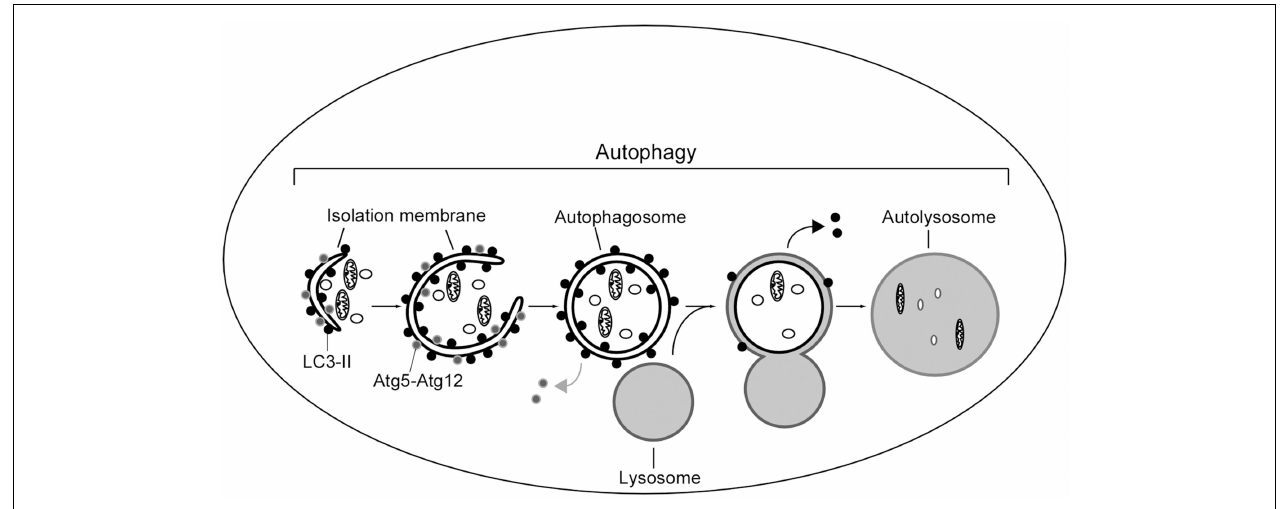
elongation process. LC3 is recruited to the membrane in the Atg5-dependent manner. Atg5–Atg12 dissociate from the membrane upon completion of autophagosome formation, while LC3 (-II) remains on the autophagosome membrane. Atg5 is required for elongation of the isolation membrane.